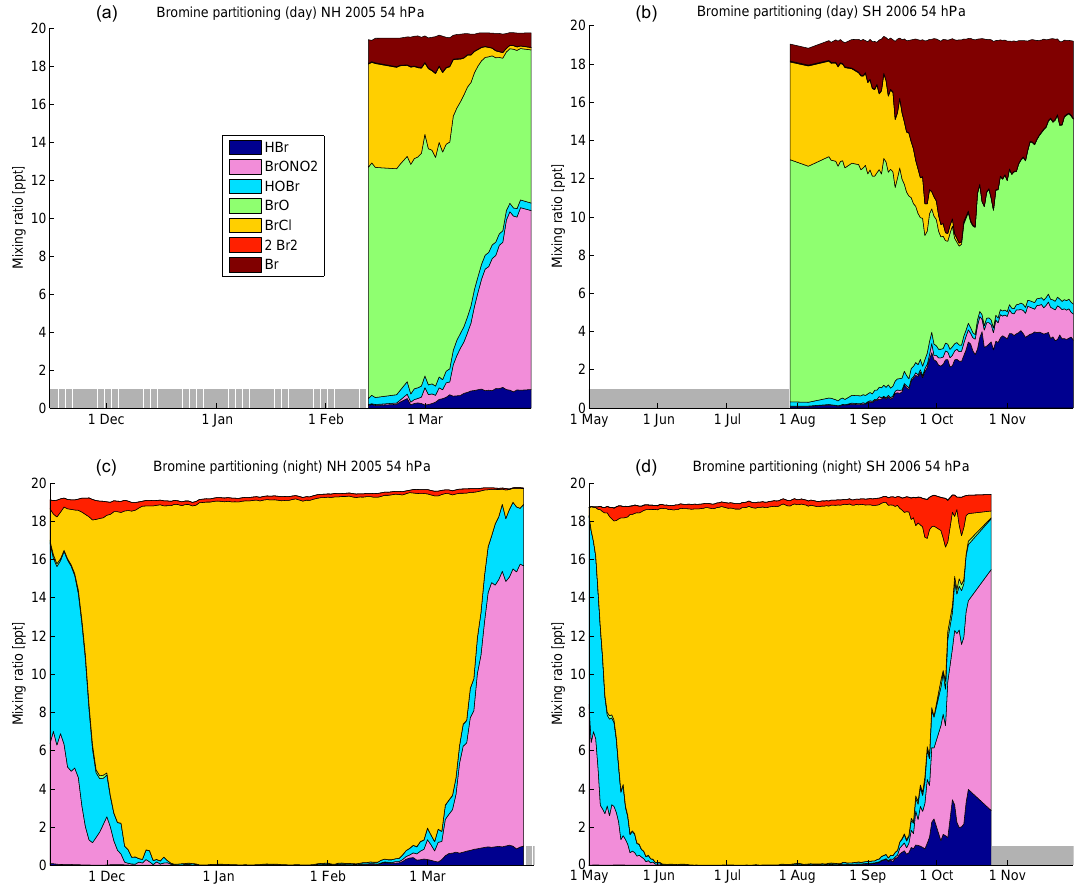
Figure 18. Vortex-averaged partitioning of inorganic bromine species for the Arctic winter 2004–2005 (a, c) and the Antarctic winter 2006 (b, d) at 54hPa. Panels (a, b) show daytime averages (parts of the vortex where the solar zenith angle is smaller than 80 ◦ ). Panels (c, d) show nighttime averages (parts of the vortex where the solar zenith angle is larger than 100 ◦ ). Days without sufficient data for averaging are not shown (grey